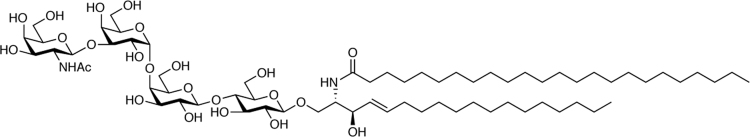
Representative structure of human erythrocyte-derived globoside. Globoside derived from human erythrocyte predominantly contains C24 fatty acids [2]. This figure illustrates globoside containing C24:0 fatty acid.